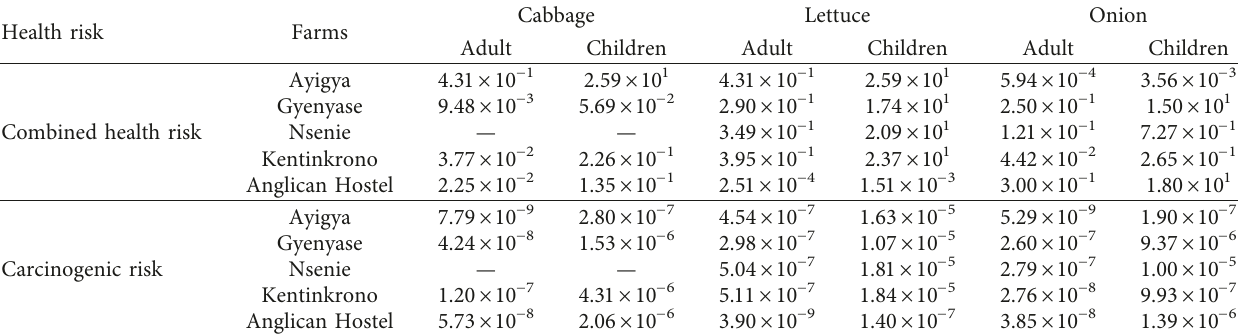
Table 7: Combined health and carcinogenic risks of multiple residues of organochlorine pesticide in vegetable samples. Health risk